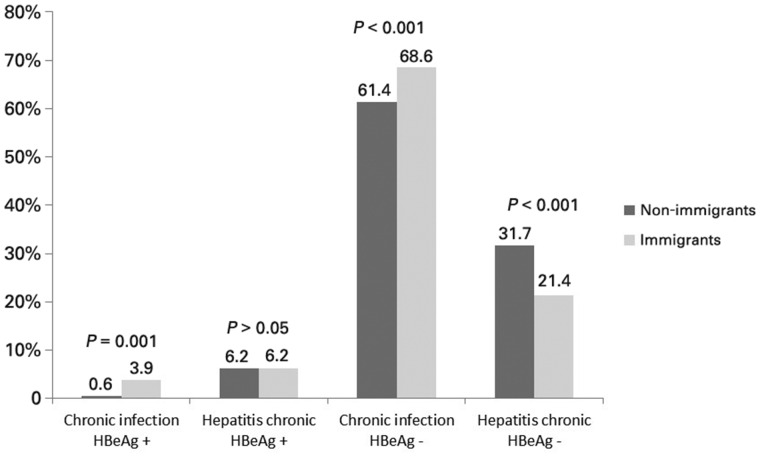
Disease liver stage in non-immigrants and immigrants.